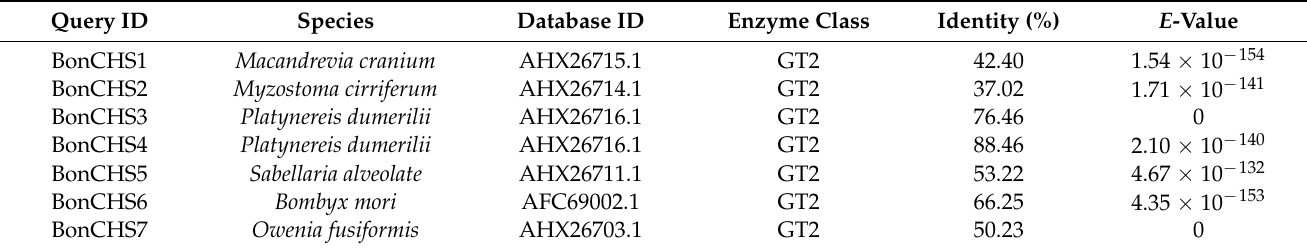
Figure 2. Multiple sequence alignment of CHSs from lophotrochozoan species—23 CHS genes from annelids and 22 from mollusks were used. Gene types are marked next to the name (A2, B2, C2, and D2 for groups A, B, C, and D in type 2 and T1 for type 1). Two highly conservative motifs (EDR and QRRRW) are indicated in bold red. The color code is followed by physicochemical properties. Table 5. The top-hit BLAST results against CAZy